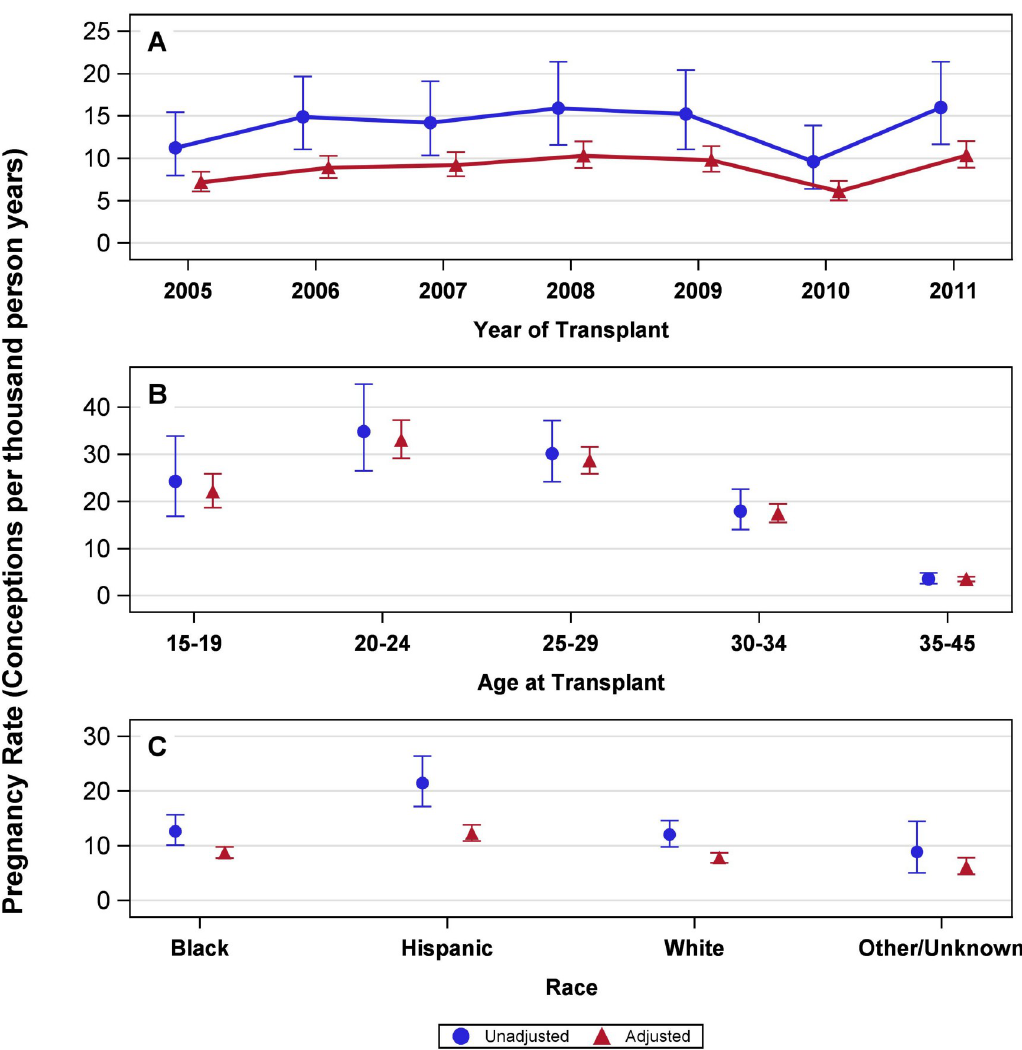
Fig 2. Adjusted and unadjusted rates of pregnancy in transplant recipient of child-bearing age (A) by year of transplant, (B) by age at transplant, and (C) by race. (A) The pregnancy rates by year of transplant, unadjusted and adjusted by age and race, and 95% confidence intervals; P value < 0.0001 for difference in rates across seven groups by year of transplant. 2005, 11.3 (8.0–15.4) and 7.2 (6.1–8.4); 2006, 14.9 (11.1–19.6) and 8.9 (7.7–10.3); 2007, 14.2 (10.3–19.1) and 9.2 (7.9–10.7); 2008, 15.9 (11.6–21.4) and 10.3 (8.8–12.0); 2009, 15.2 (11.1–20.4) and 9.8 (8.4–11.4); 2010, 9.6 (6.4–13.9) and 6.1 (5.0–7.3); 2011, 16.0 (11.7–21.4) and 10.4 (8.9–12.0). (B) The pregnancy rates by age at transplant, unadjusted and adjusted by race and year of transplant, and 95% confidence intervals; P value < 0.0001 for difference in rates between age groups. 15–19 years, 24.3 (16.8–33.9) and 22.0 (18.7– 25.9); 20–24 years, 34.8 (26.5–44.9) and 33.0 (29.2–37.3); 25–29 years, 30.2 (24.2–37.2) and 28.6 (25.9–31.7); 30–34 years, 17.9 (14.0–22.6) and 17.4 (15.6–19.4); 35–45 years, 3.6 (2.6–4.9) and 3.5 (3.0–4.0). (C) The pregnancy rates by race, unadjusted and adjusted by age at transplant and year of transplant, and 95% confidence intervals; P value < 0.0001 for difference in rates across four races. Black, 12.7 (10.1–15.7) and 8.7 (7.8–9.8); Hispanic, 21.4 (17.2–26.4) and 12.3 (10.9–13.8); White, 12.1 (9.9–14.6) and 7.8 (7.0–8.7); Other/unknown, 8.9 (5.1–14.5) and 6.2 (4.9–7.8).